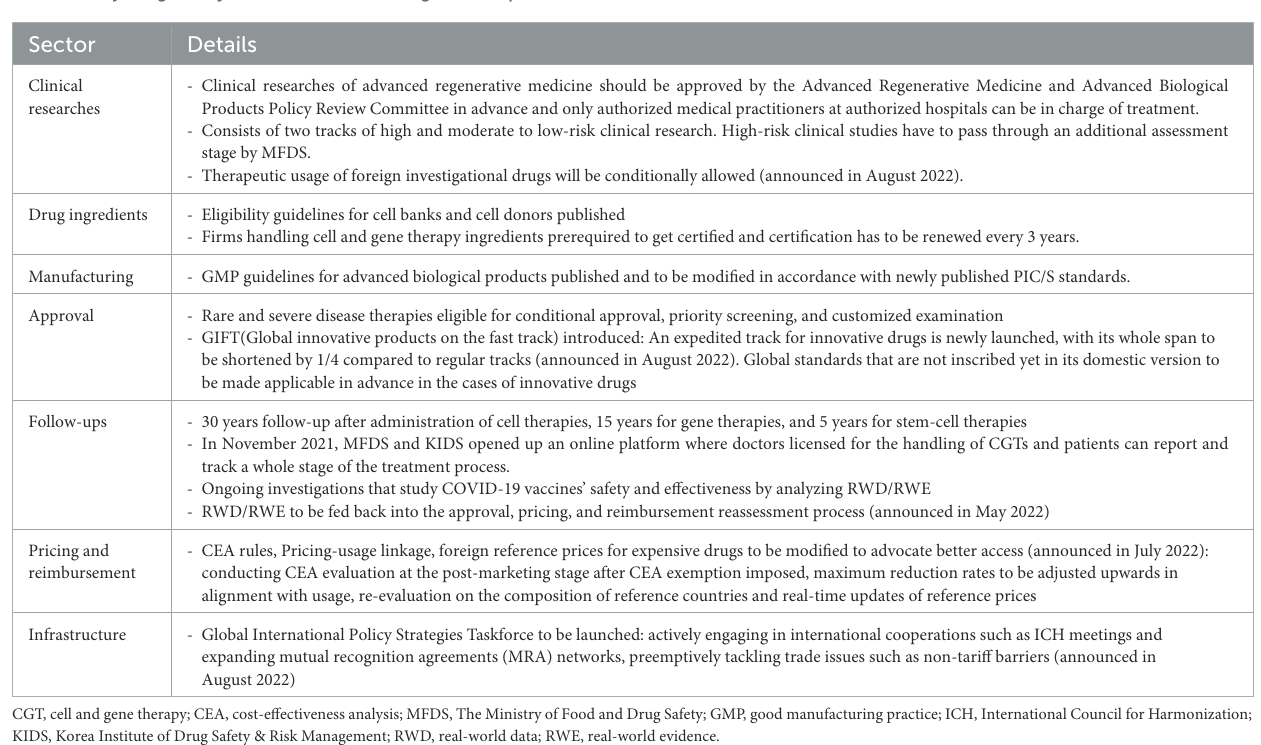
TABLE 2 Major regulatory framework for cell and gene therapies in South Korea (2, 5,